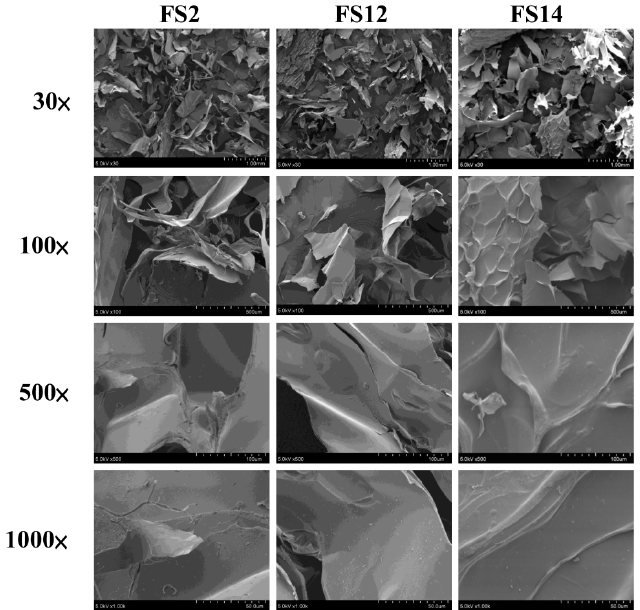
Figure 1. Scanning electron microscopy (SEM) micrographs of lyophilized FS2, FS12, and FS14. Magnifications are 30×, 100×, 500×, and 1000×, respectively.